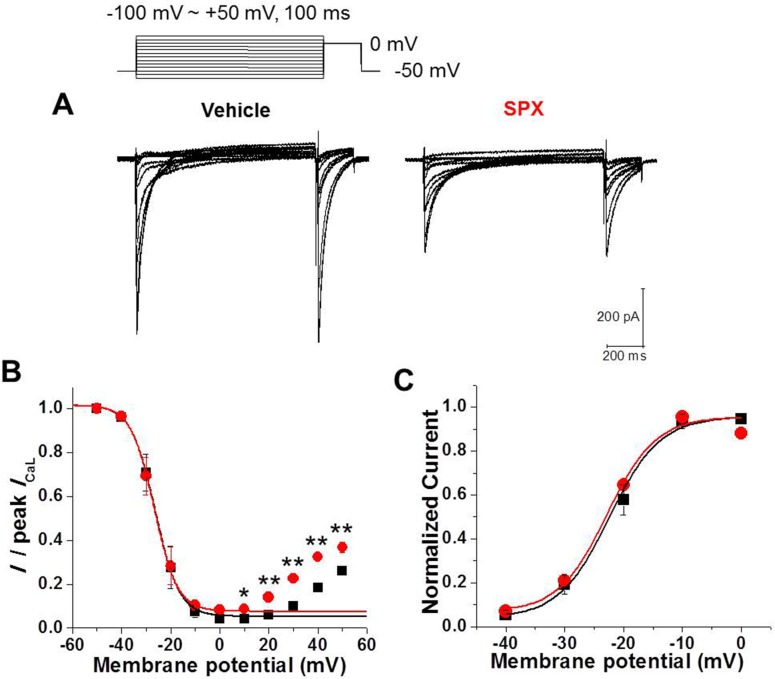
Effect of SPX on the steady-state inactivation of ICaL.A, The steady-state inactivation levels were measured by using double-pulse protocol. B, Steady-state inactivation curves for the ICaL in the absence and presence of SPX (300 μM). C, Voltage dependence of ICaL activation in the absence and presence of SPX (300 μM). The half-activation voltage was not significantly changed by SPX (n = 10, paired t-test, P > 0.05).